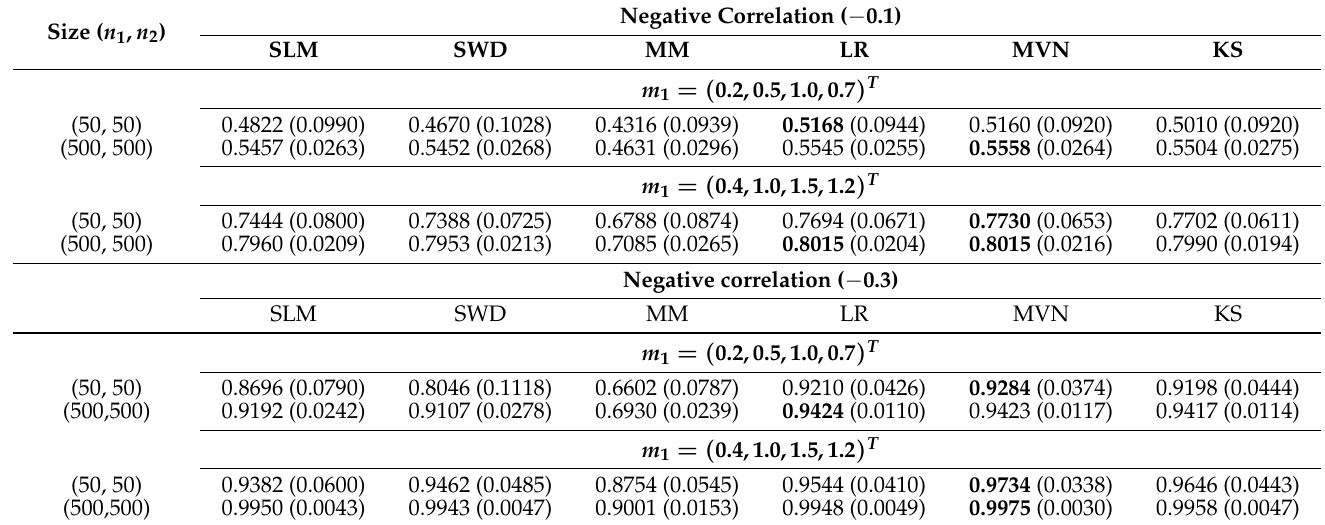
Table 13. Normal distributions: Different means and equal negative correlations. Validation.